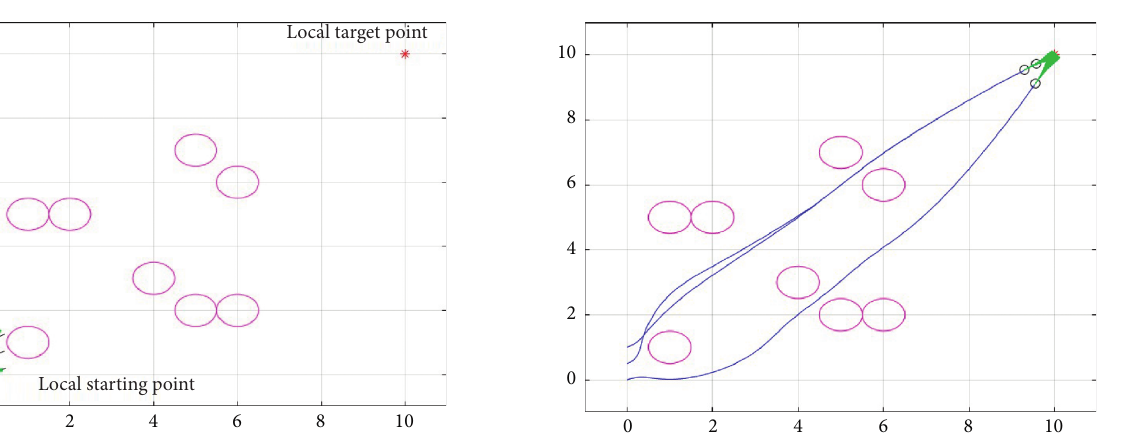
Figure 15: The positions of the robots: t �